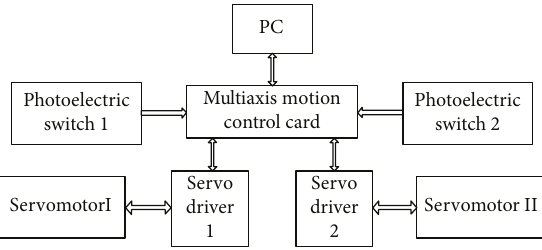
Figure 17: Schematic of the overall control